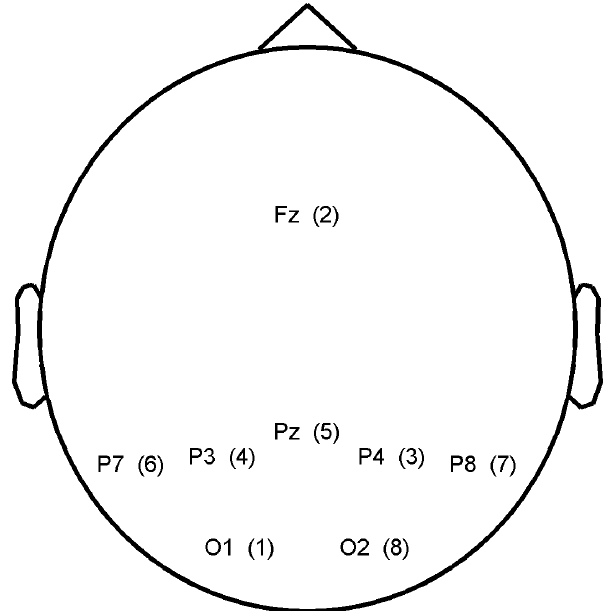
Figure 5. Electrode scores after electrode selection based on the maximization of the mean SSNR across subjects ( SS common